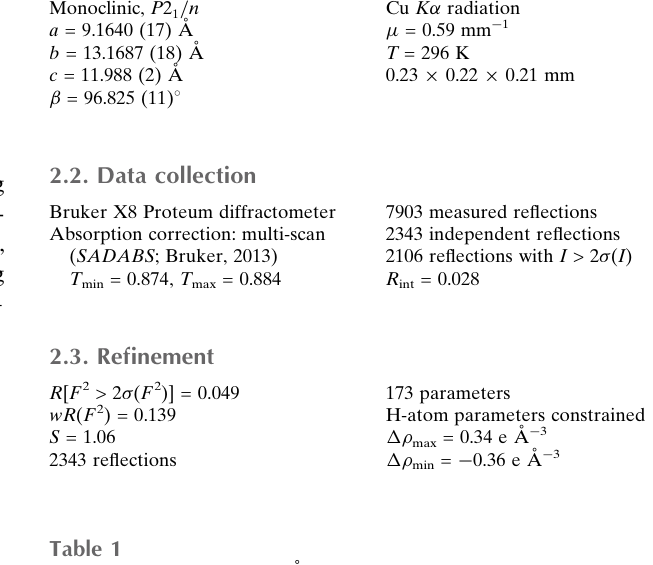
Hydrogen-bond geometry (A˚ , (cid:3)